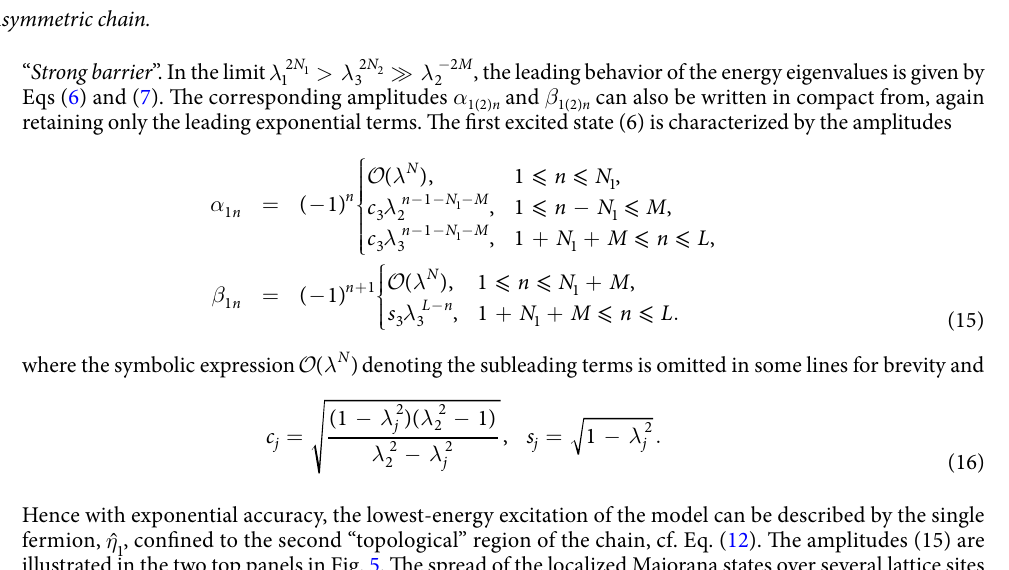
Figure 6. Majorana amplitudes (20) of the two nearly zero-energy eigenstates of the symmetric Ising-Kitaev chain (1)–(2) in the piece-wise uniform applied field (3) with λ λ = = 1/2 The red dots represent the result of the exact numerical diagonalization. The curves represent the analytic solutions given in Eq.